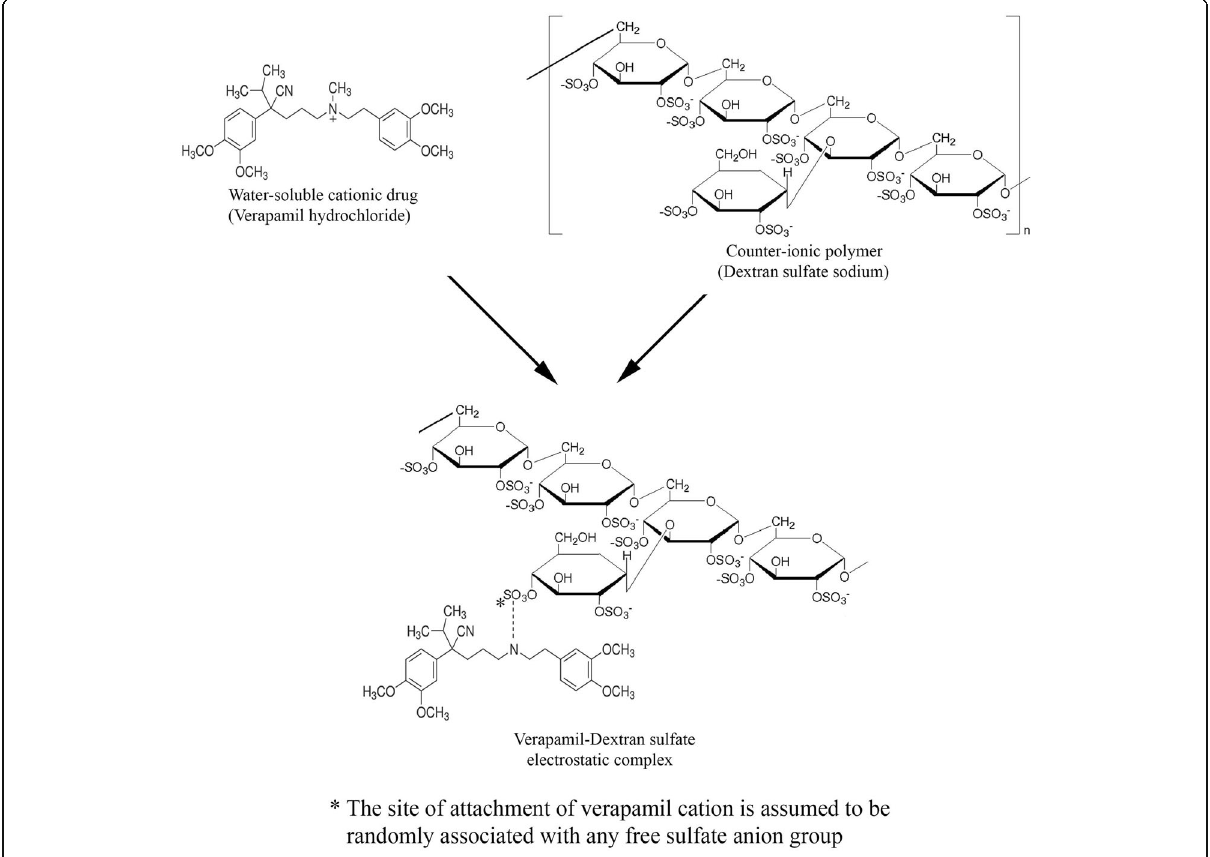
Fig. 1 Formation of electrostatic complex of water-soluble cationic drug verapamil hydrochloride and counterion polymer dextran sulfate